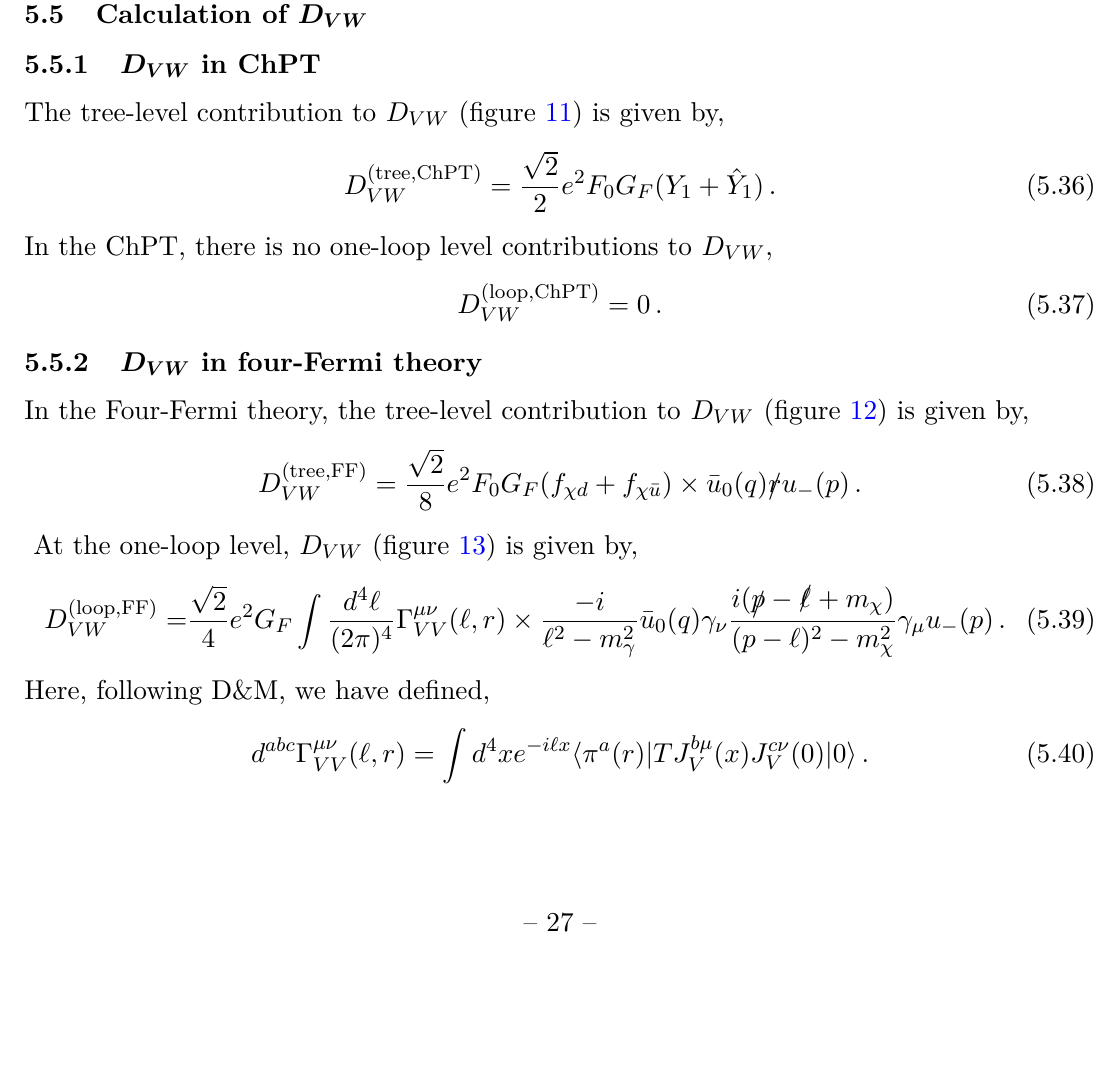
( x ) q 8 ∗ ( x ) . Note that the vertices are provided by the quark V W